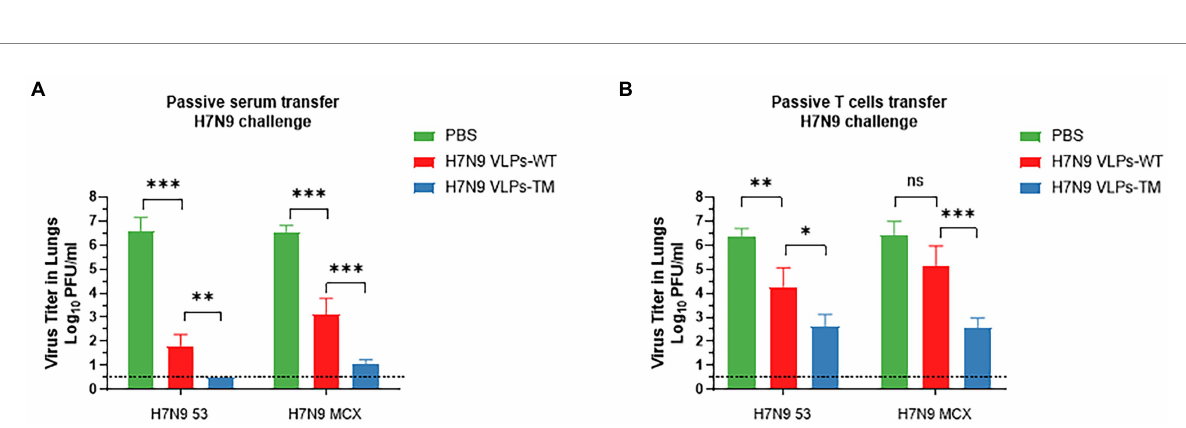
(Figure 5A, yellow arrow). In general, serum passive immunization was better than T cell passive immunization, and the protective effect of H7N9 VLPs-TM was better than that of H7N9 VLPs-WT. The protective effect of the two H7N9 VLPs was more obvious against homologous virus H7N9–53 than against heterologous virus H7N9-MCX.